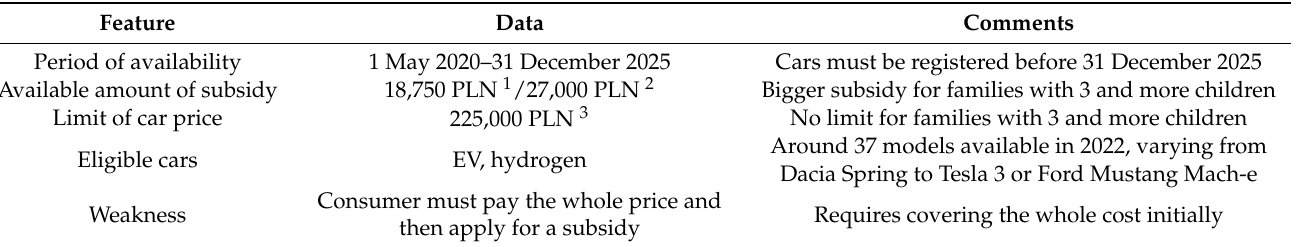
Table 1. Details of “My EV” scheme for individual buyers, launched by the Polish government in